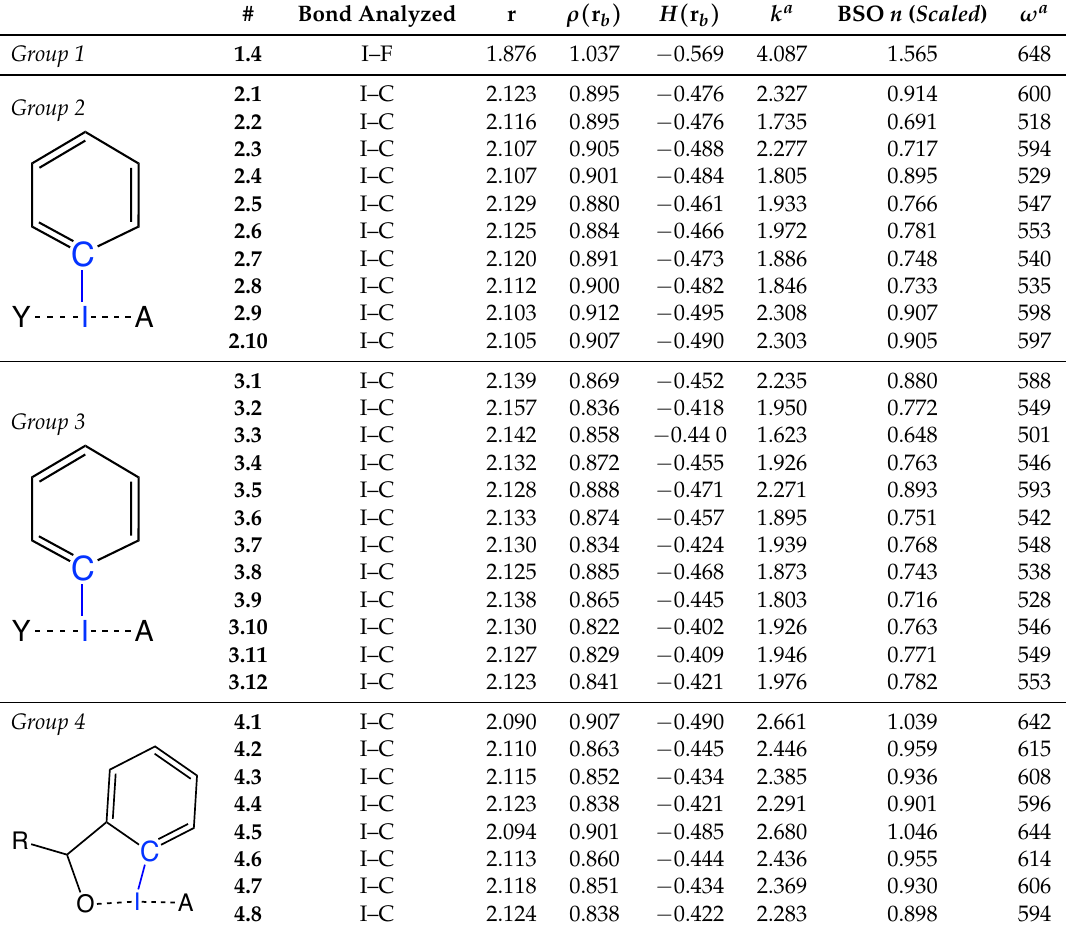
Table 2. r, ρ ( r b ) , H ( r b ) , and local vibrational data for I-equatorial ligand (I–F, I–C) interactions